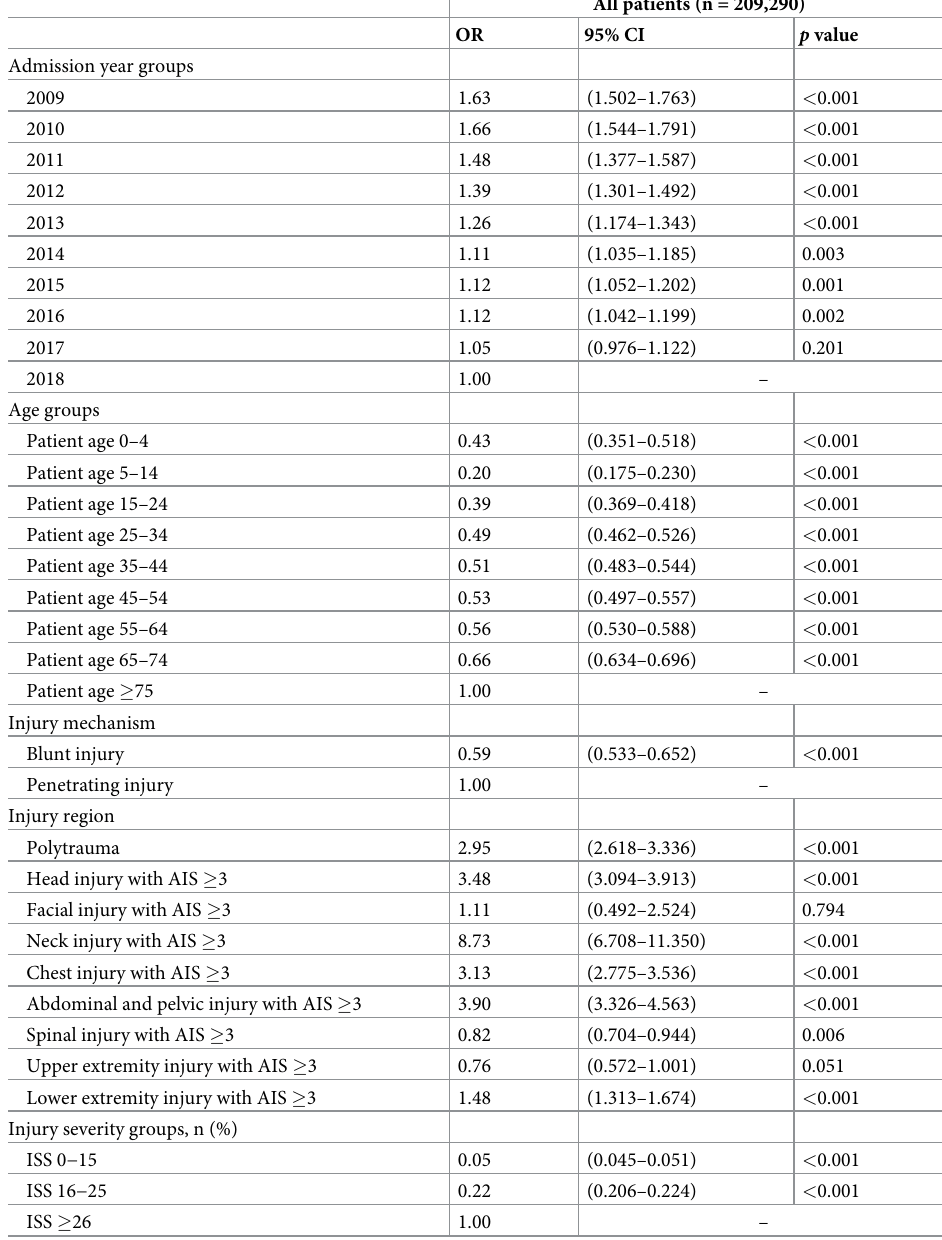
Table 2. Multivariable logistic regression analysis of in-hospital mortality among injured